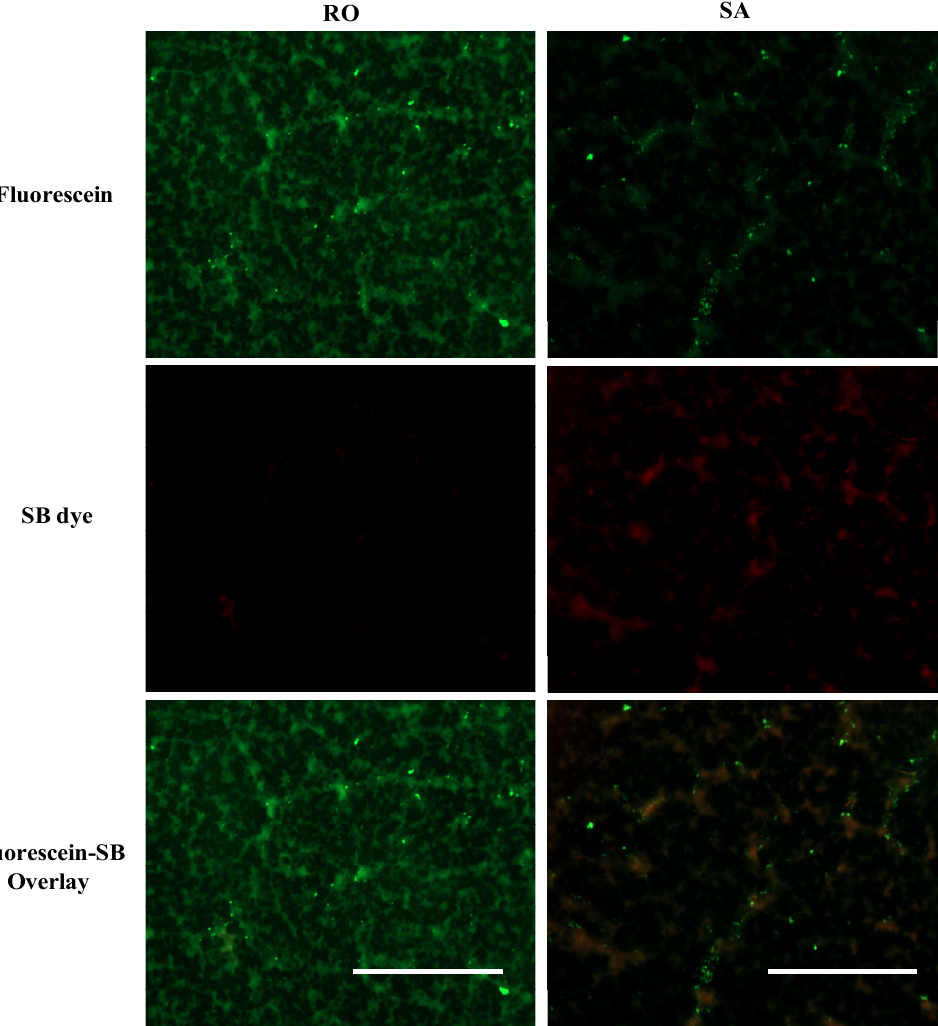
Figure 6. Representative fluorescent microscopy (FM) images of chitosan (CHI)/hyaluronan (HA)/fluorescein (6-FAM) DNA multilayer films exposed to 200 µM SB dye showing co-localization (Fluorescein-Sulforhodamine B (SB) overlay; orange) of DNA (Fluorescein; green) and SB dye (SB dye; red) fluorescence as an indication of binding. Films contain either RO DNA (left) or sulforhodamine B aptamer (SA) DNA (right). Films were prepared using the original method of deposition. Scale bar, 400